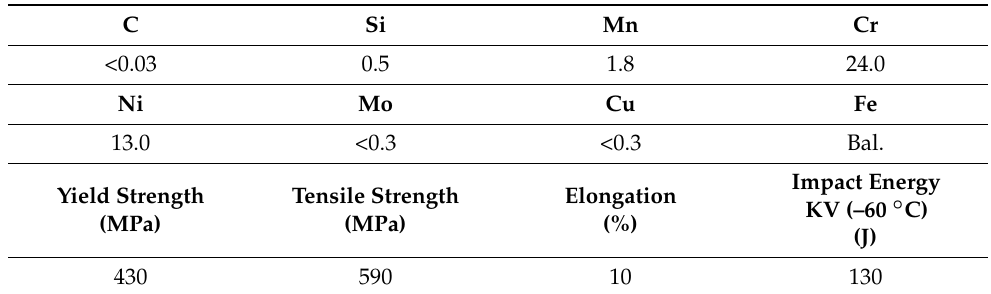
Table 4. Chemical composition (in % wt.) and mechanical properties of the additive material OK Tigrod 309L (ER309L–SFA/AWS A5.9).